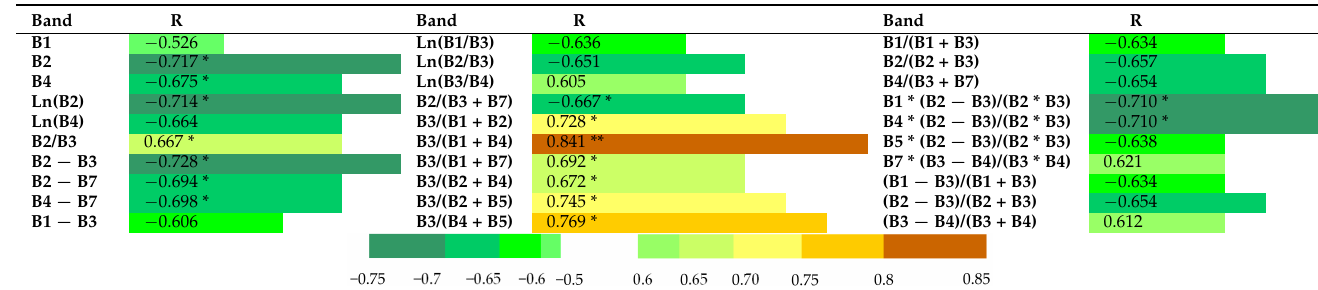
Table 1. Correlation coefficient of Landsat-5 TM band combinations with measured